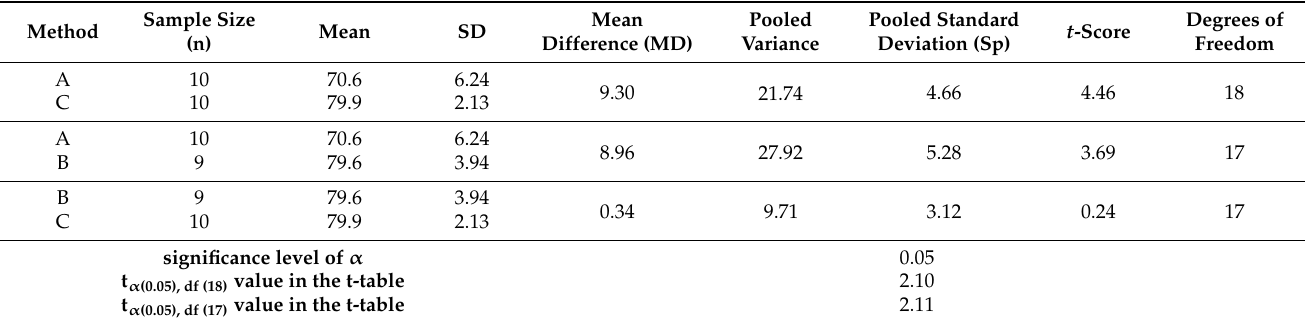
Table 4. T -score values.